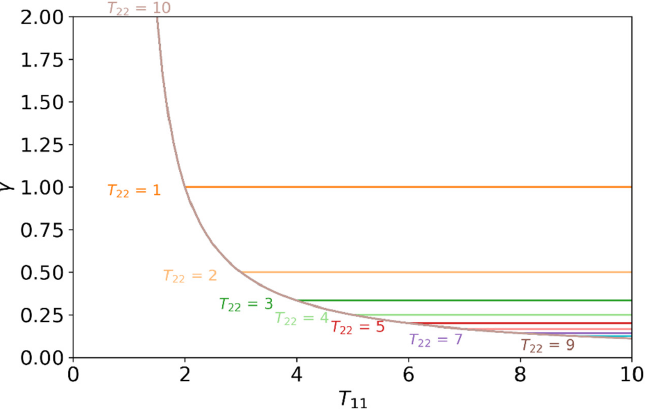
Figure 5. The simulation of the determination of γ with T 11 and T 22 .